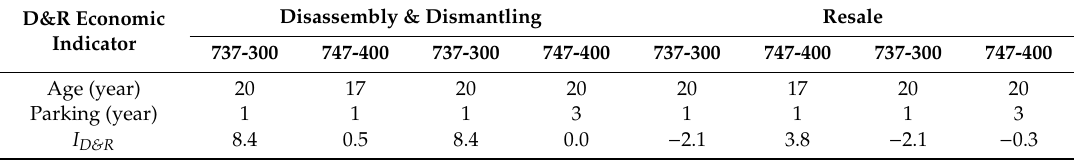
Table 12. Disposal and recycle economic indicator for 737-300 and 747-400